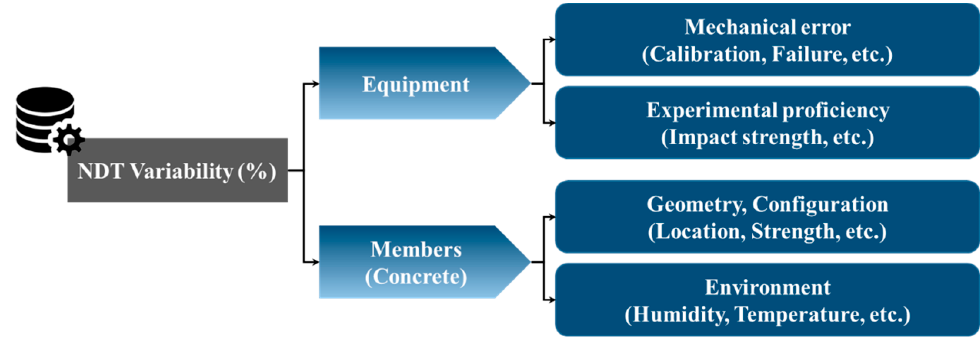
Figure 3. Concepts of NDT variability.